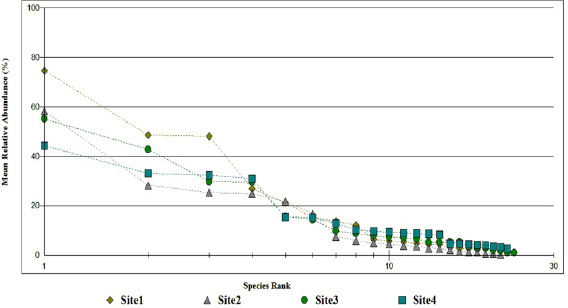
Figure 3. Whittaker plot showing the rank based abundance results of the aquatic and semiaquatic hemipterans in the four sites of Sonebeel